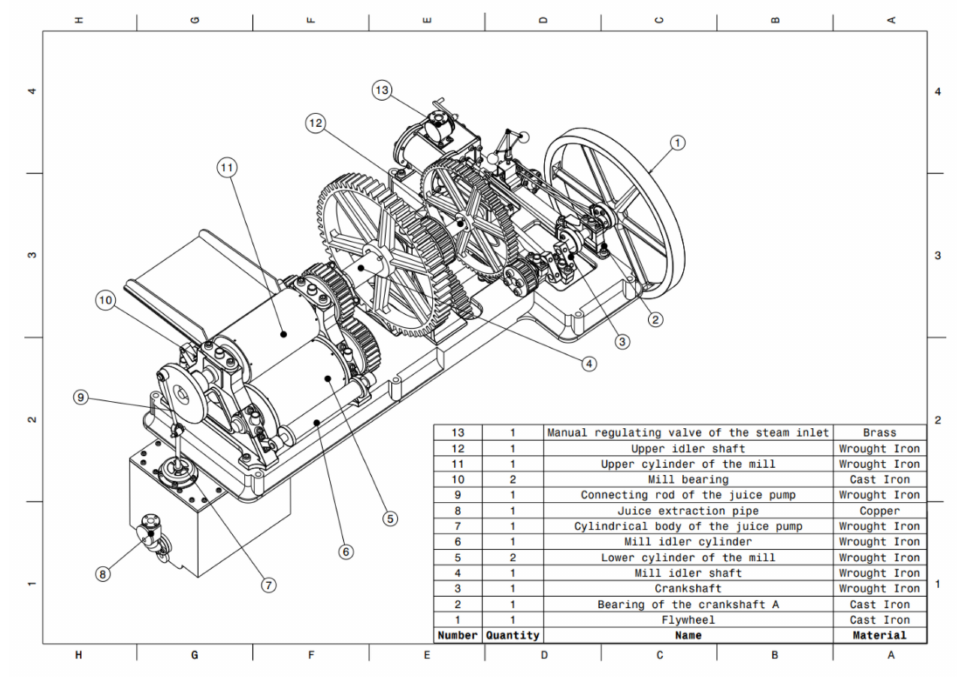
Figure 2. Assembly plan (Elements 1–13).